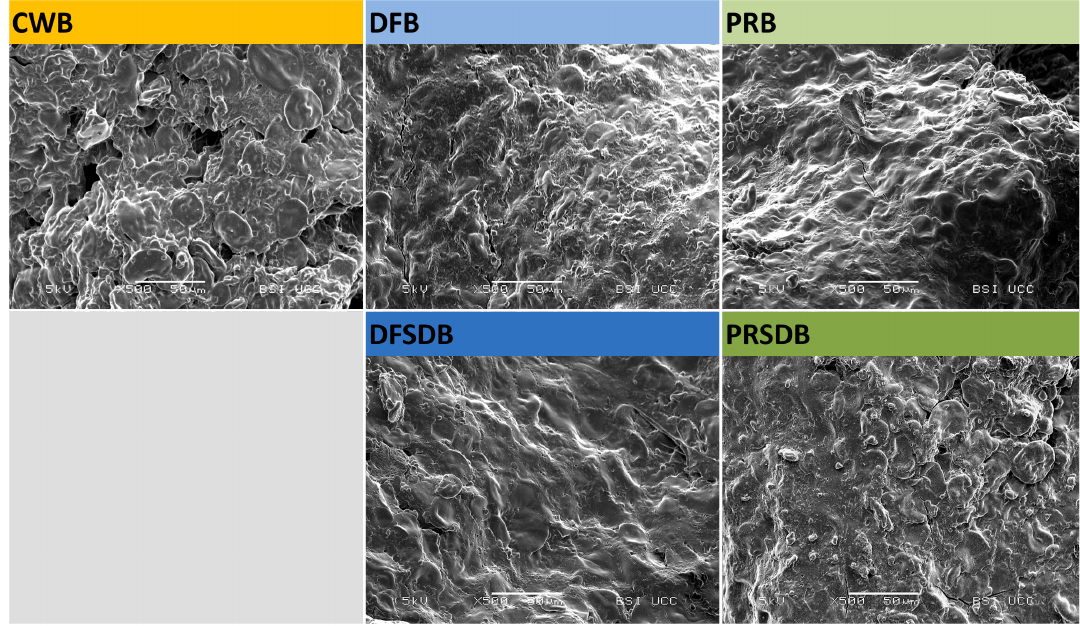
Figure 5. Micrographs (obtained by SEM) of crumb from control wheat bread and faba bean